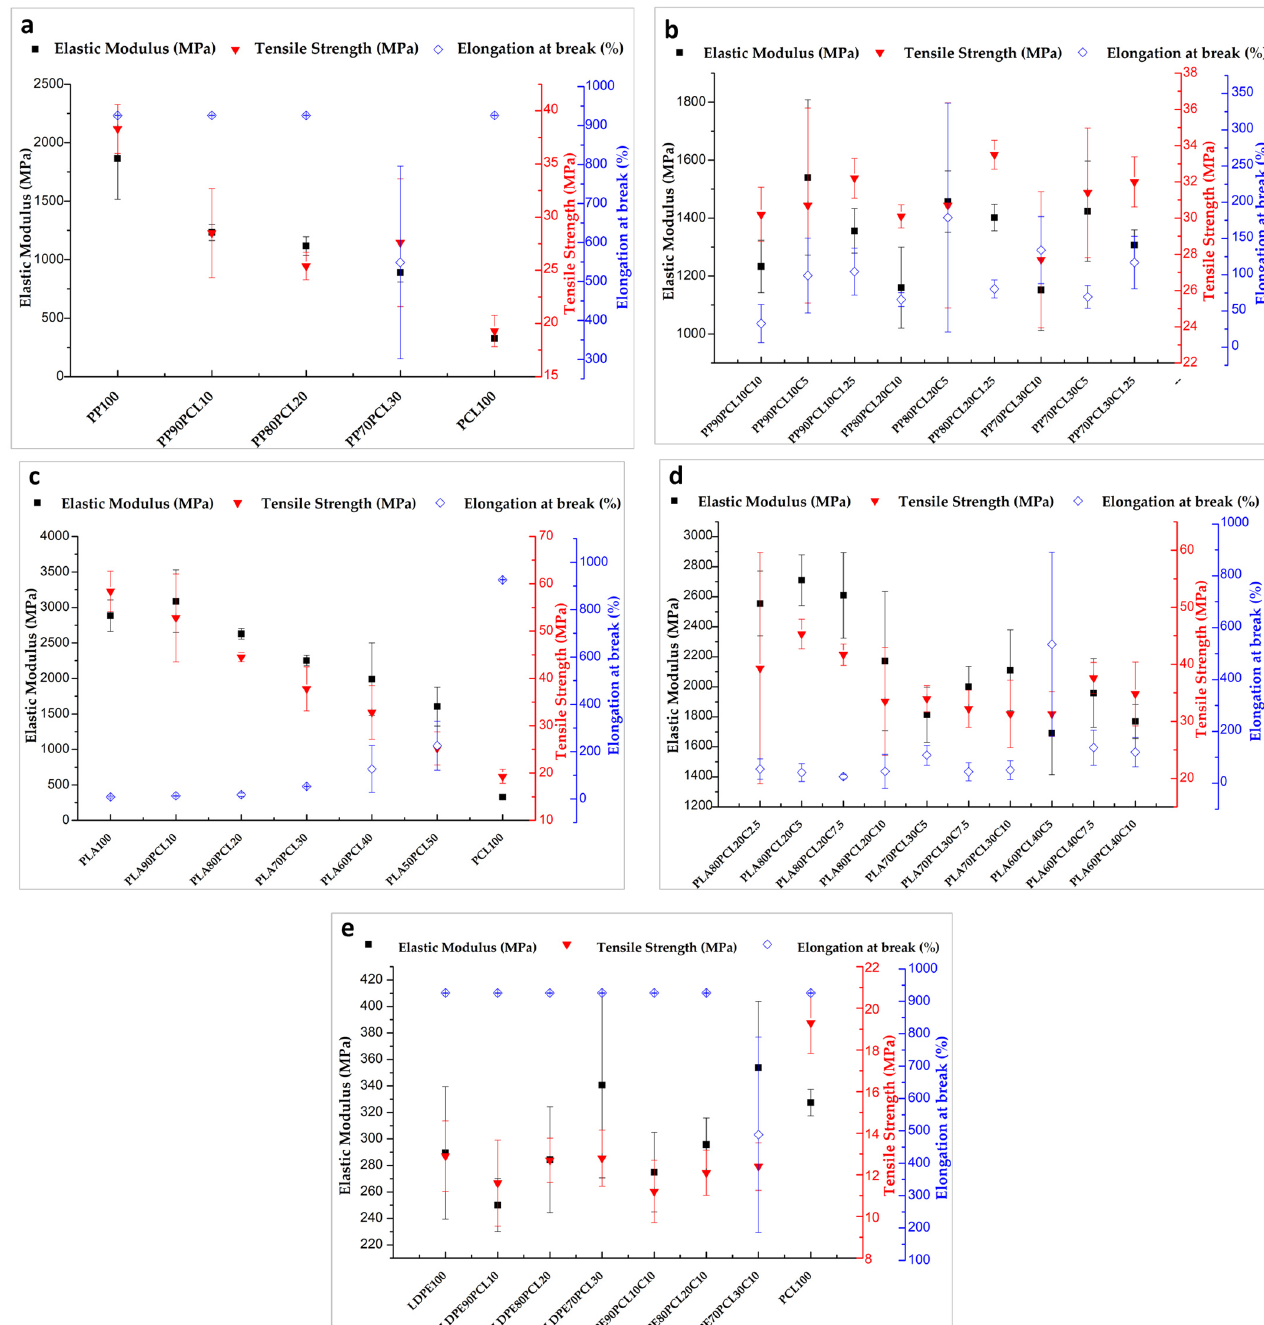
Figure 1. Stress–strain plots of ( a ) PP/PCL, ( b ) PP/PCL/PP-g-ma, ( c ) PLA/PCL, ( d ) PLA/PCL/ P-123, and ( e ) LDPE/PCL and LDPE/PCL/PE-g-ma blends. The stress–strain plots of PLA/PCL and PLA/PCL/P-123 blends are presented in Fig-